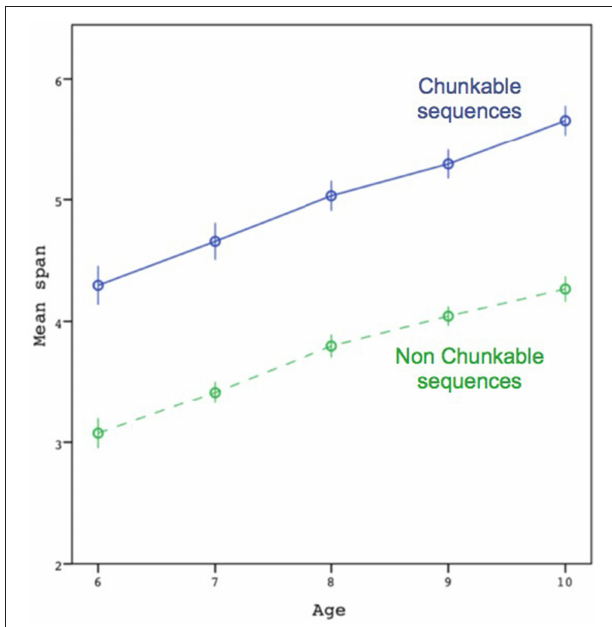
FIGURE 2 | Average maximal span attained by participants, as a function of age and chunkability of the sequences. Error bars are ± 1 standard errors. The dotted line represents the non-chunkable condition. The maximal spans on which the mean was computed were based on the individual’s highest span.